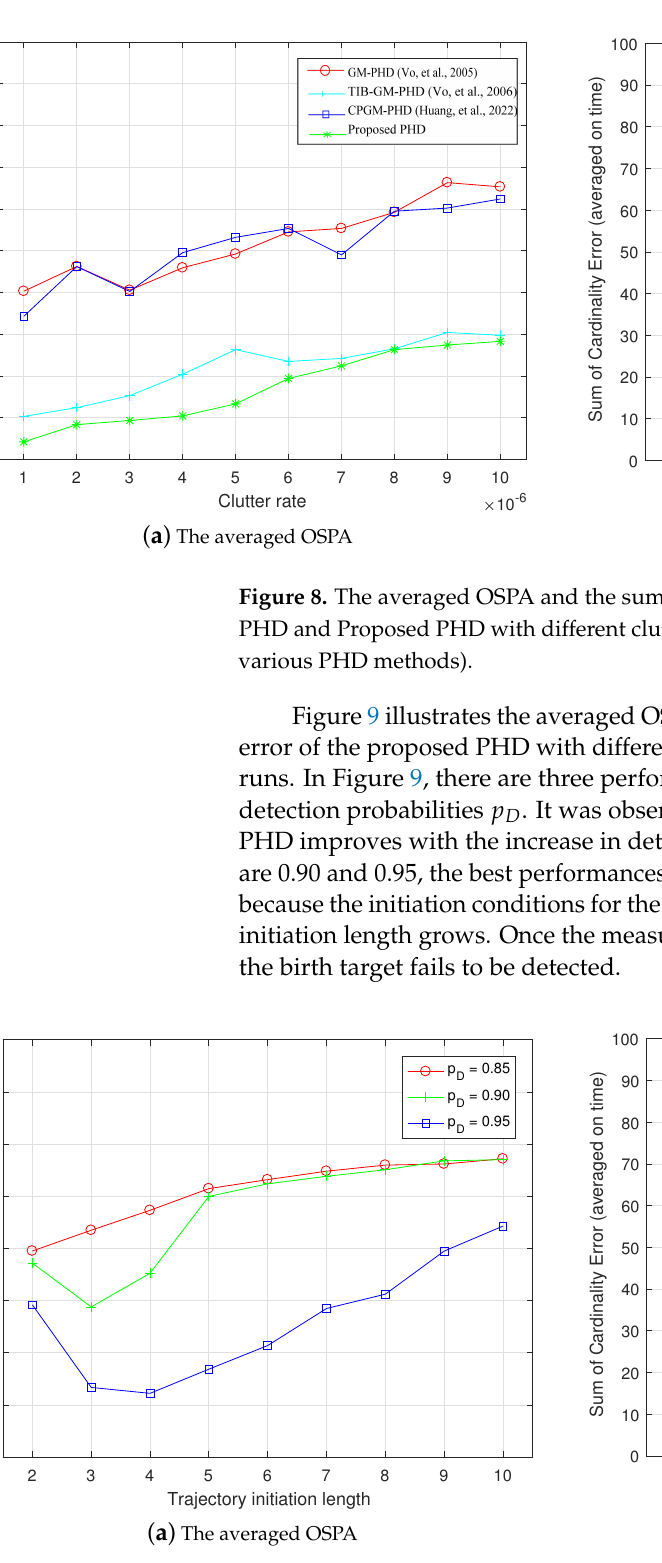
Figure 9. The averaged OSPA and the sum of cardinality error of GM-PHD, TIB-GM-PHD, CPGM- PHD and Proposed PHD with different trajectory initiation